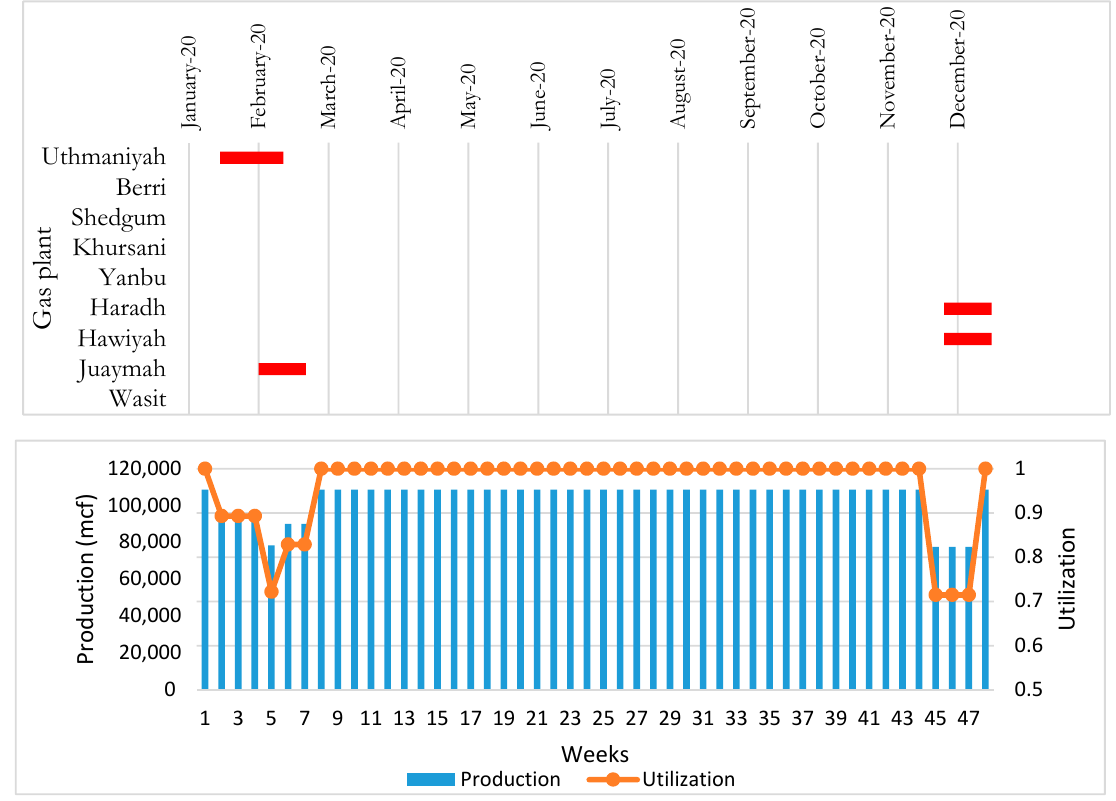
Figure 5. Gas plants maintenance scheduling, production plans, and utilization (year 1).